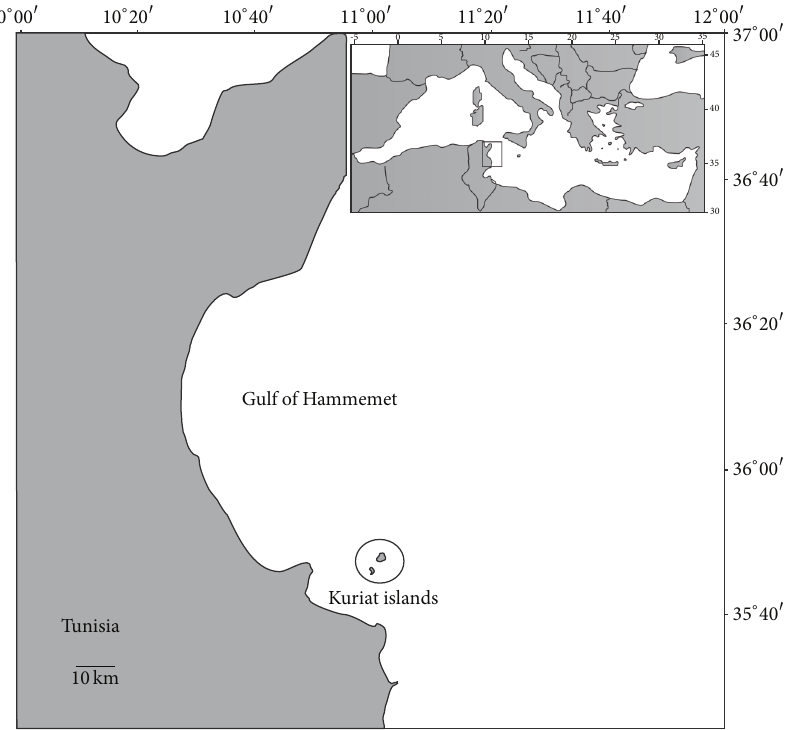
Figure 1: Geographic position of Kuriat